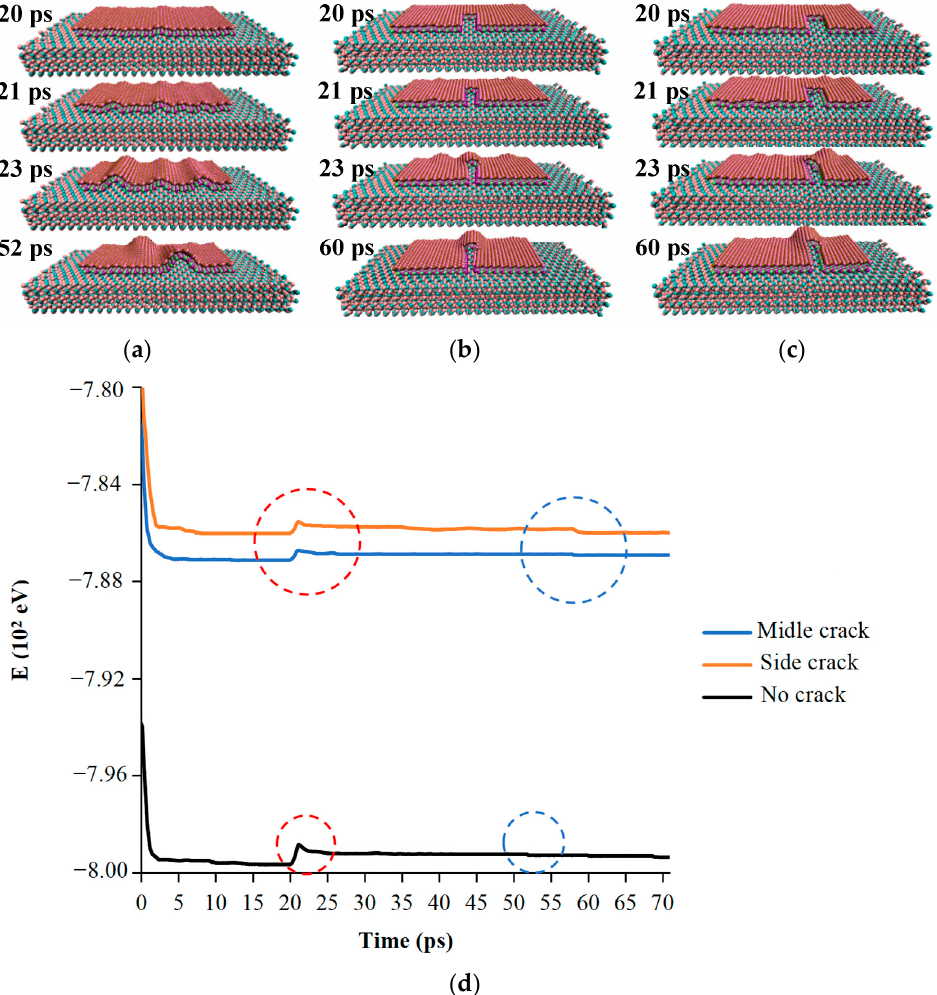
Figure 12. Morphological changes of h-BN flakes and energy change with the simulation time: ( a ) Intact h-BN flake model. ( b ) h-BN flake model with a crack in the middle region. ( c ) h-BN flake model with a crack in the side region. ( d ) Energy change of the models with time.